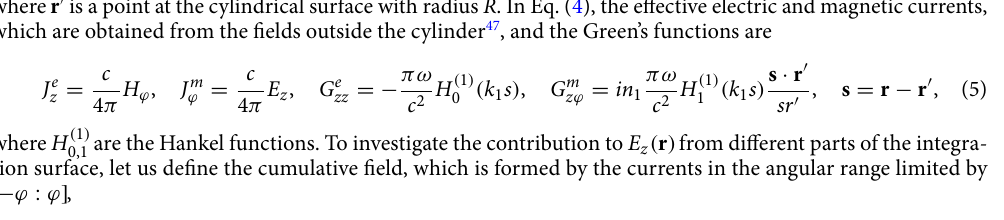
(cid:31) ) as a function of R / (cid:31) for several values of n M | | M x i / R for several values of n 2 | | =